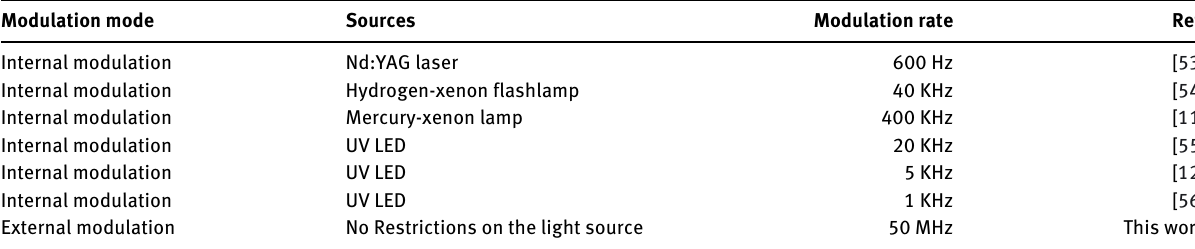
Table 1: Comparison of modulation strategies in UV